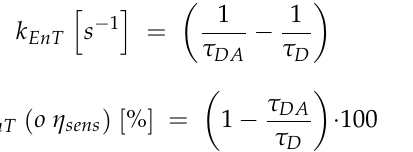
Table 2. Experimental lifetimes ( τ ) of Tb-PhPOSS (D) and TbEu-PhPOSS (DA), collected by monitor- ing the main emission of Tb 3+ at 545 nm ( 5 D 4 - 7 F 5 electronic transition) under irradiation at 370 nm. The Tb 3+ → Eu 3+ energy transfer rate ( k EnT ) and efficiency ( E EnT ) parameters are also reported.